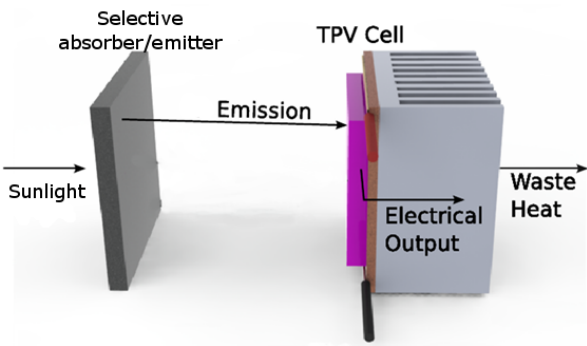
Fig. 1. Illustration of the basic design of solar thermophotovoltaic systems for converting sunlight into electricity. The eflciency may be limited by reradiation from the selective absorber, nonideal emission from the selective emitter and losses in the PV cell